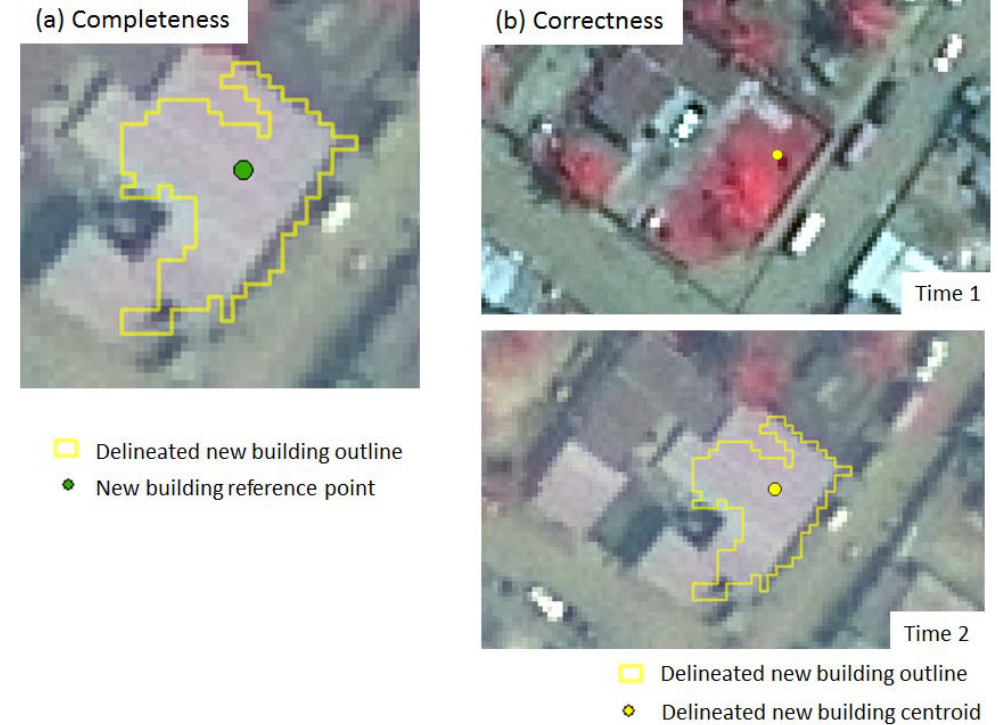
Figure 2. Accuracy assessment of delineated new building maps. The assessment consisted of calculating (a) completeness and (b) correctness values. Completeness quantifies the matched percentage between delineated new building polygons and new building reference points. Correctness is the percentage of matching between delineated new building points and pan-sharpened multispectral (PSMS) reference images. Time 1 = 12 April 2002. Time 2 = 18 January